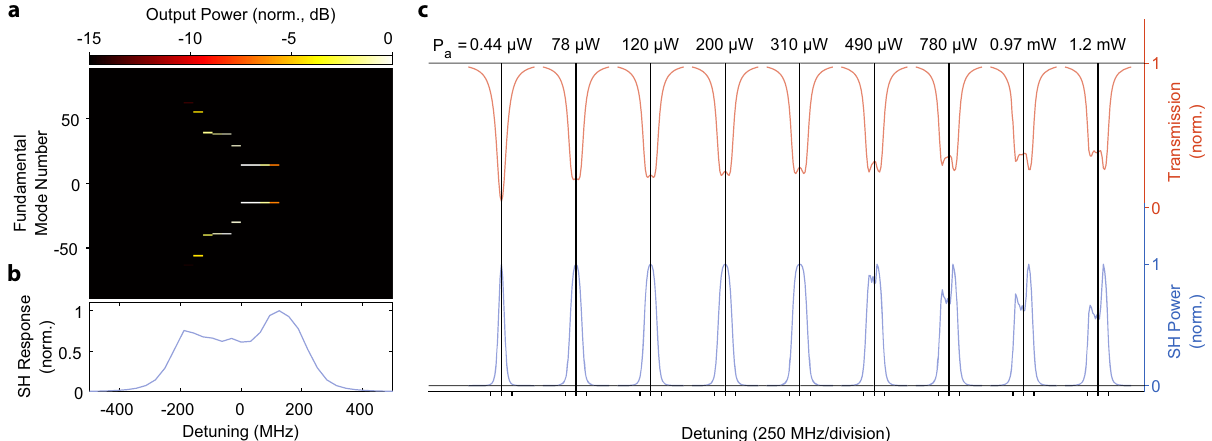
Fig. 8 Simulated effect of 10% disorder in the mode-to-mode loss rates on the cascaded OPO. a Cascaded OPO signal as a function of pump detuning, simulated at 0.97 mW of pump power. b Second Harmonic lineshape corresponding to the cascaded OPO in panel ( a ). c Lineshape evolution as a function of power, asymmetry is developed around 490 μ W, lower than in the